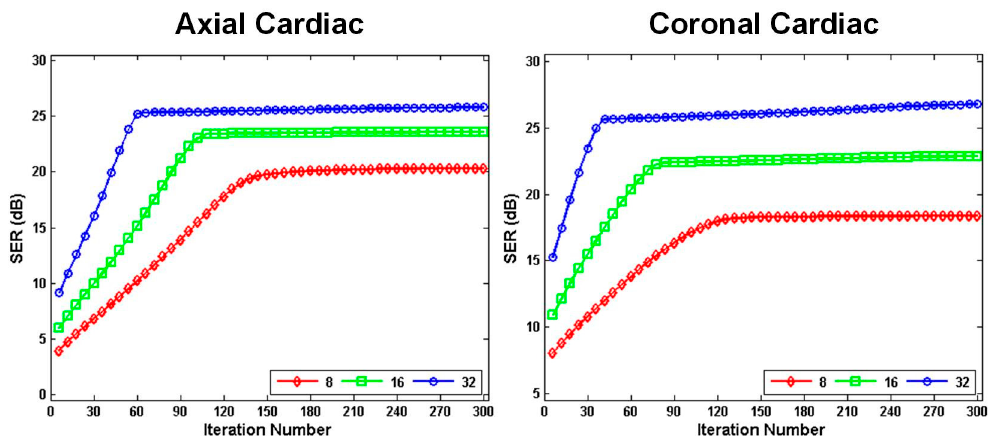
Figure 8. Convergence property of the proposed k - t NCRPCA. Progression of the objective quality metric SER for in vivo axial (left) and coronal (right) cardiac datasets with respect to iteration number. The undersampled ( k , t ) -space measurements were generated from 8, 16 and 32 radial projections.